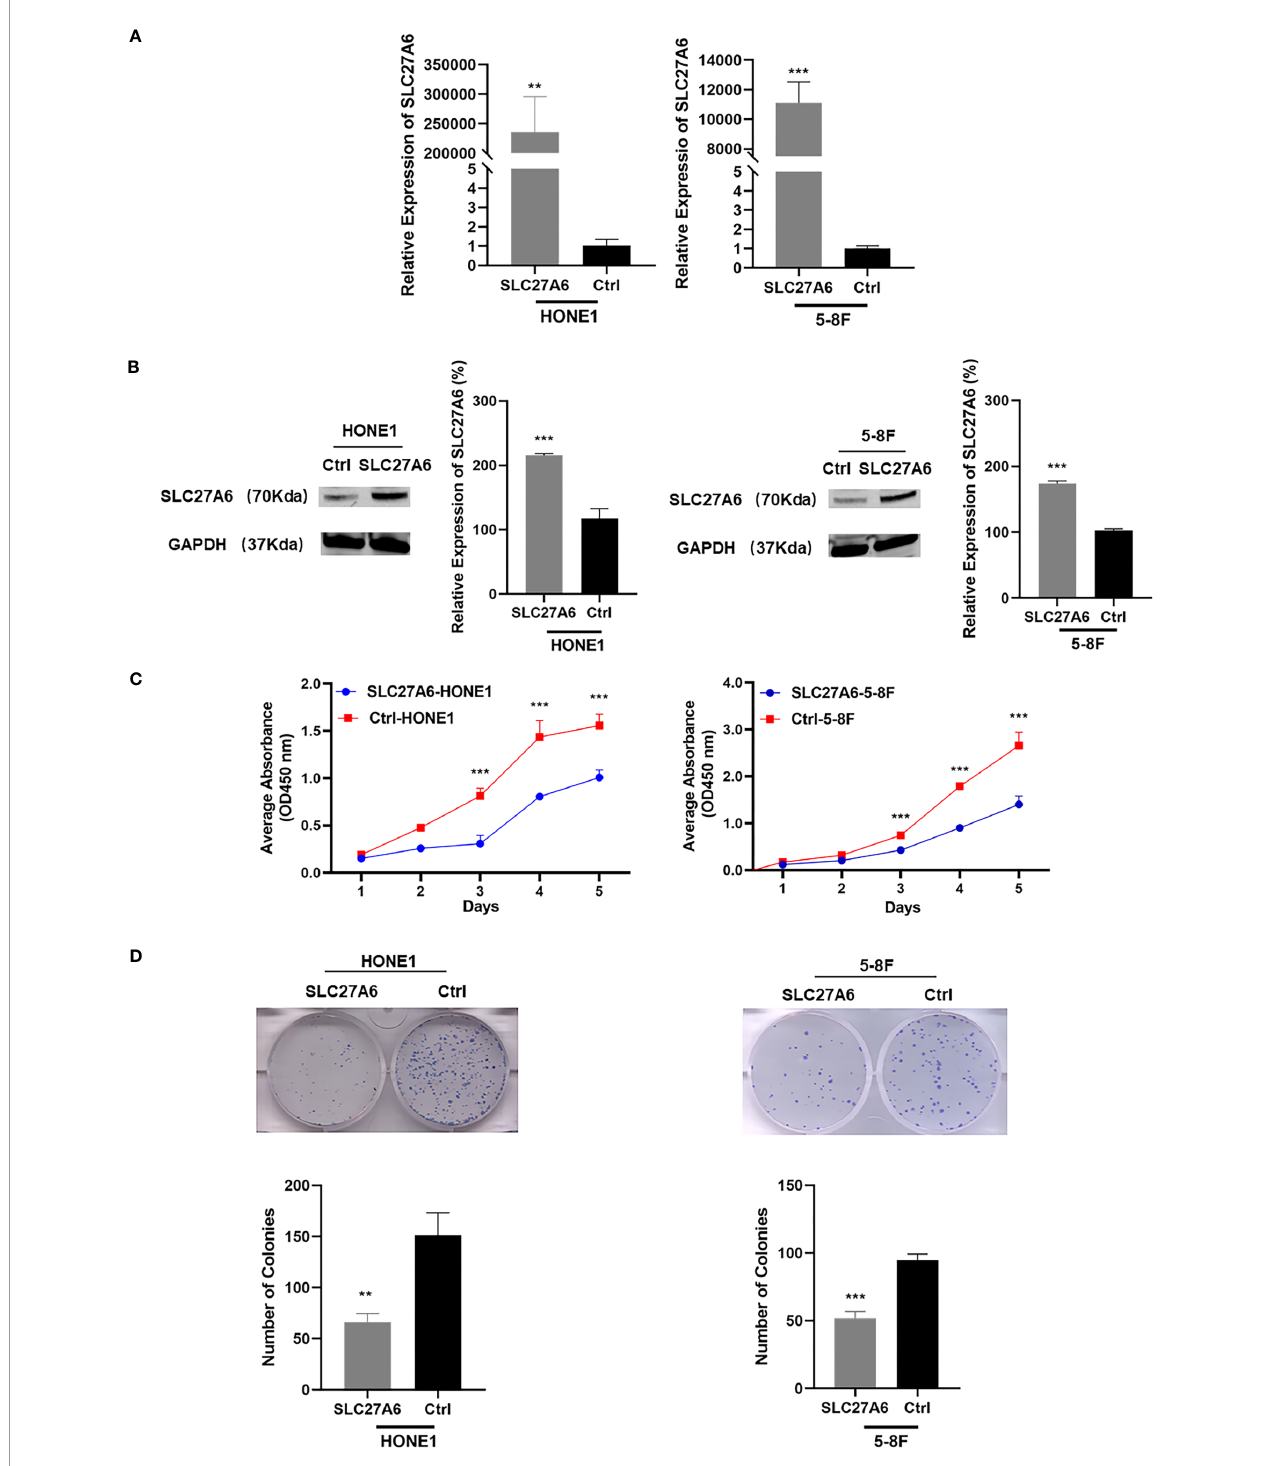
FIGURE 3 | Overexpression of SLC27A6 suppresses cell proliferation. (A, B) SLC27A6 mRNA expression in stably transfected NPC cells (HONE1, 5-8F) was con fi rmed by qRT-PCR (A) and western blotting (B) . NPC cells were stably transfected with control vector plasmid pCMV6-entry as the control group (control group, Ctrl-HONE1, Ctrl-5-8F). (C) Cell proliferation in stably transfected NPC cells (HONE1, 5-8F) was measured by CCK-8 assay (OD=450 nm). (D) Colony formation assay tested in stably transfected NPC cells (HONE1, 5-8F). ** P < 0.01 and *** P <